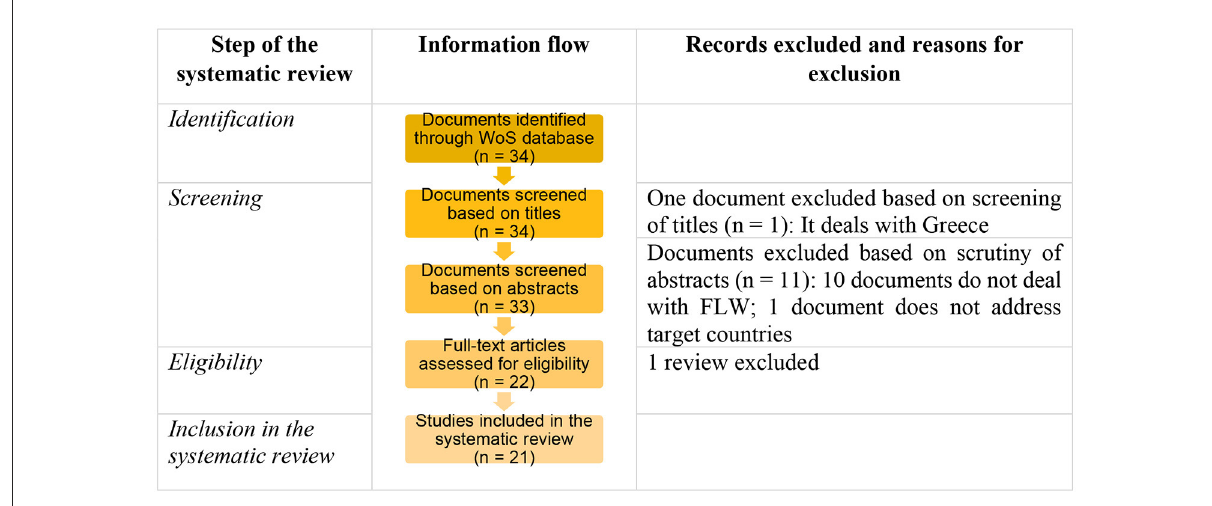
FIGURE1 Process of the search and selection of documents.